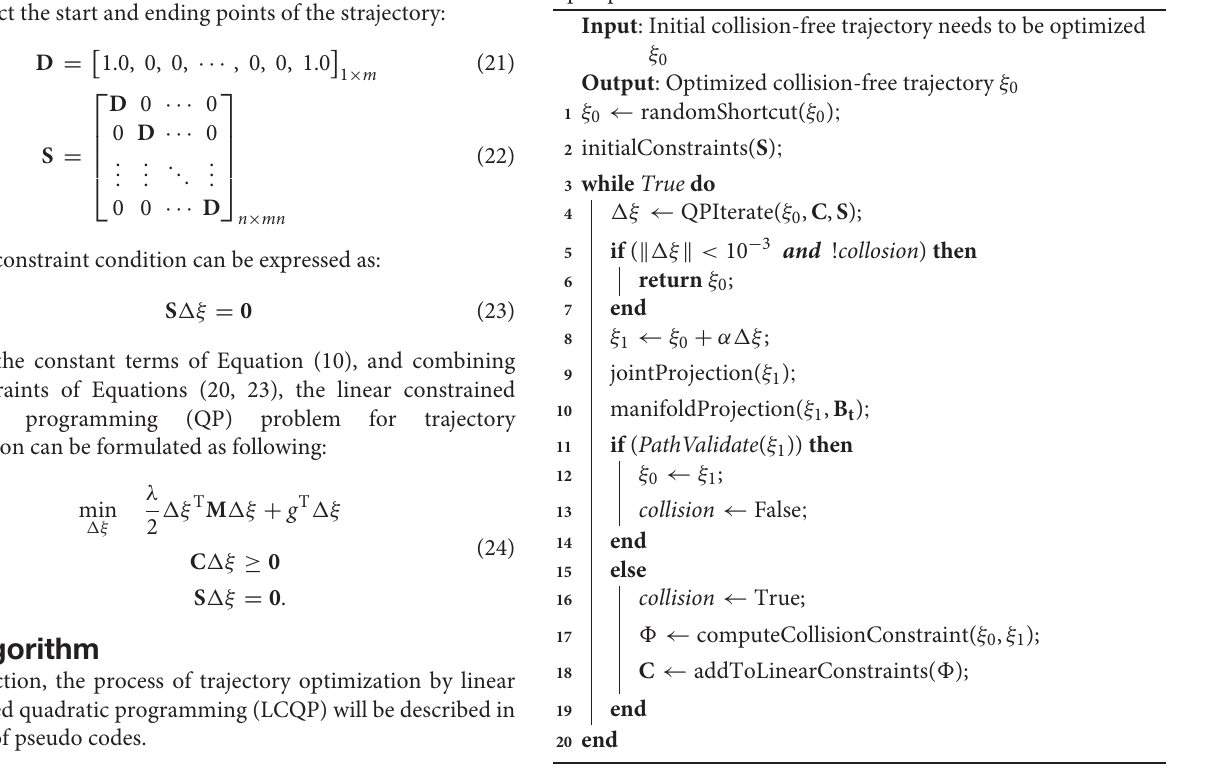
Algorithm 1: Quadratic Program-based motion trajectory